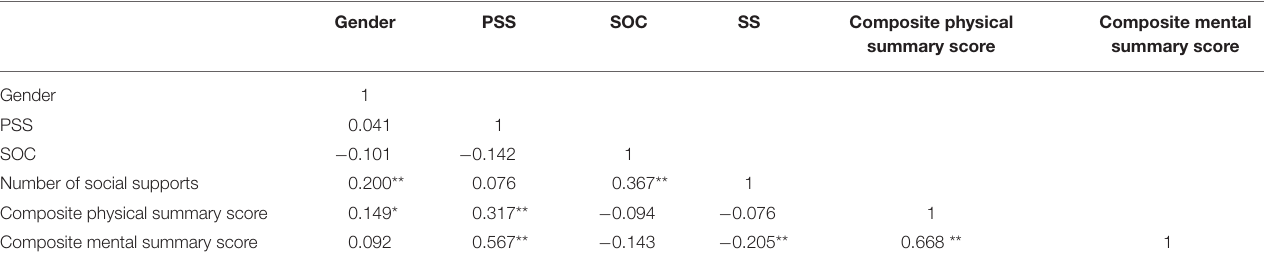
TABLE 2 | Correlations between the independent and dependent variables